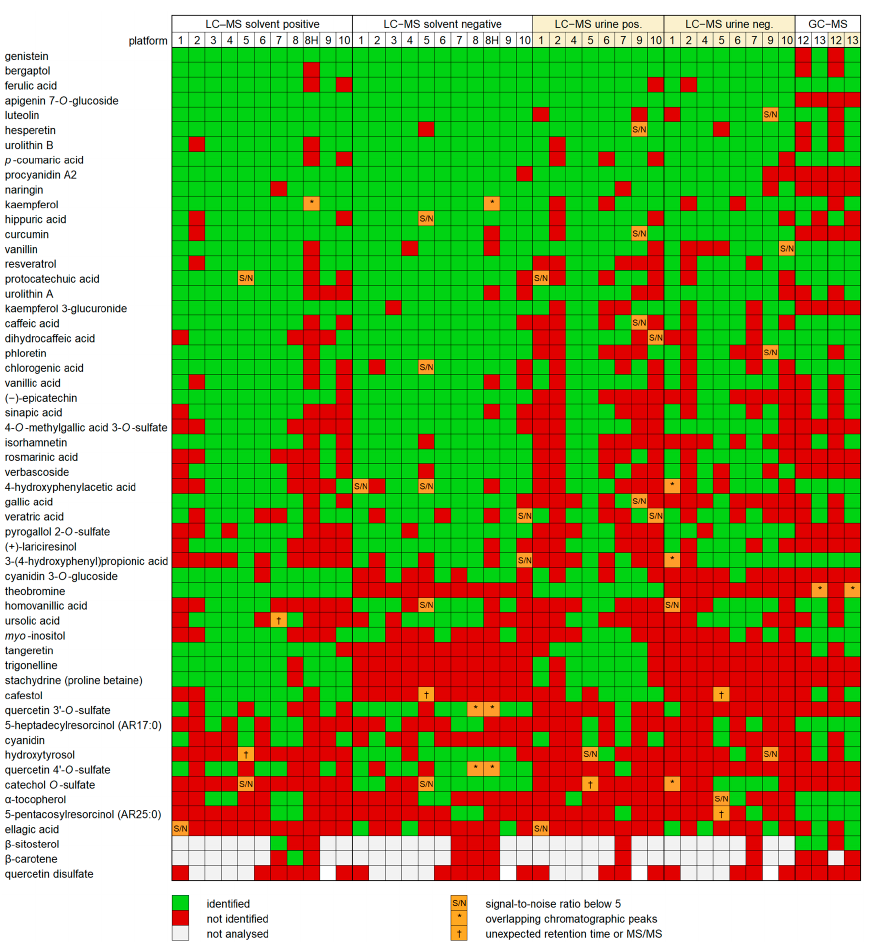
Figure 3. The positive identifications (green), undetected (red) and uncertain identifications (orange) of the chemical standards in different platforms, arranged in a descending order of the number of identifications in all analyses. Quercetin disulfate was not detected in any platform, suggesting that it was not present in the standard mixtures.